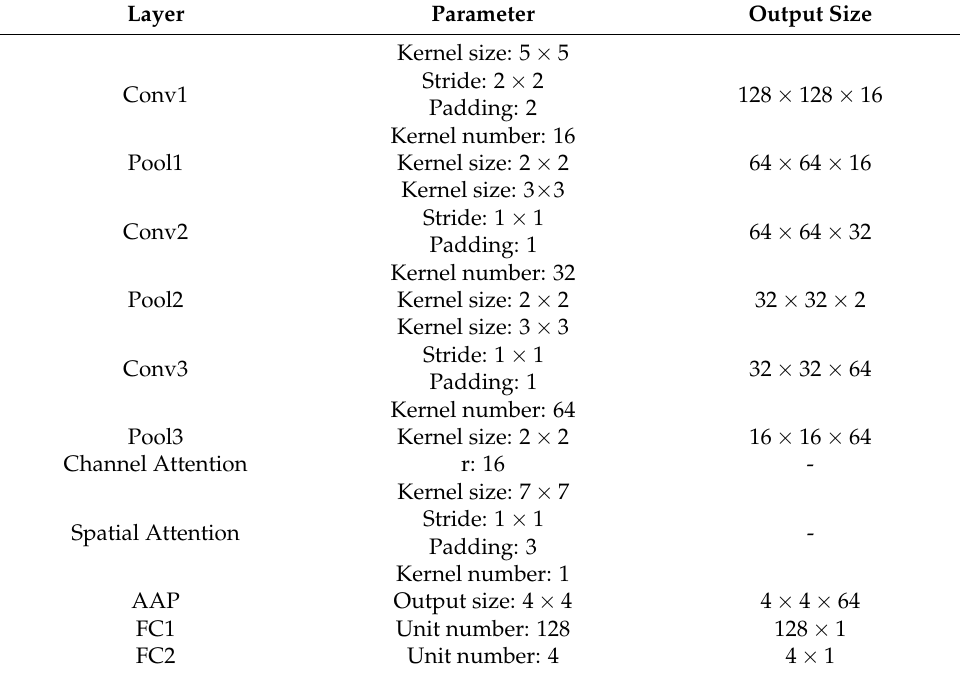
Table 2. Parameter details of